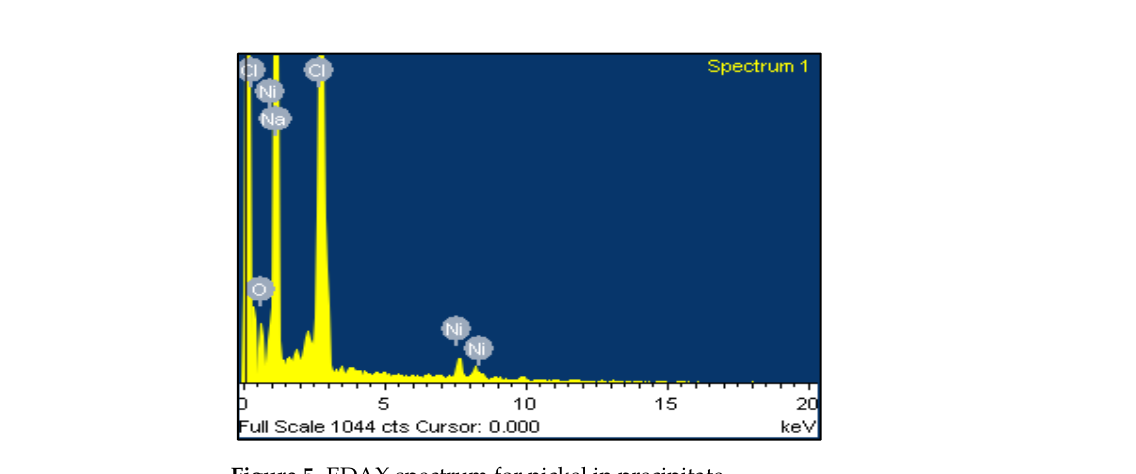
Figure 5. EDAX spectrum for nickel in precipitate. Table 4. Experimental design and performance results.